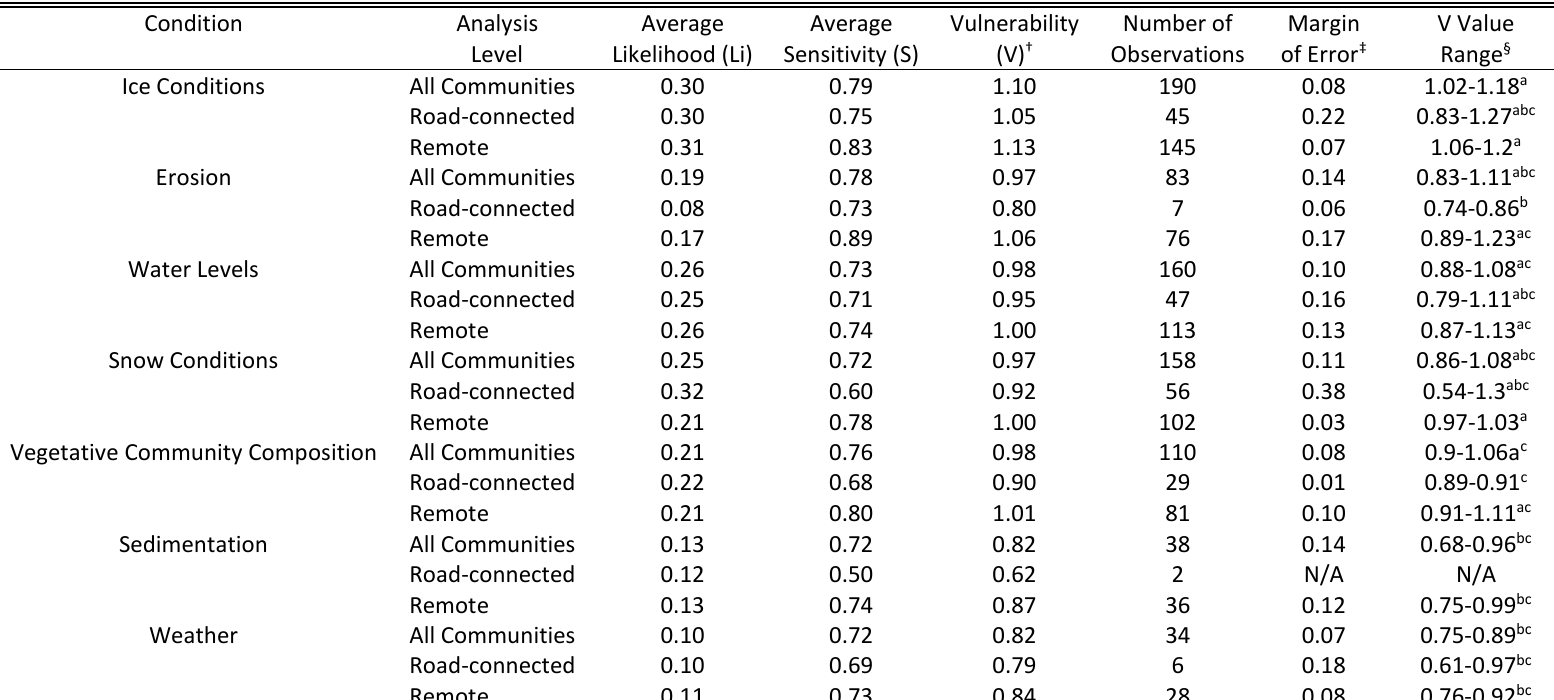
Table A2.1. Mean values for vulnerability analysis of combined GPS and interview data at the community, road-connected and remote levels.